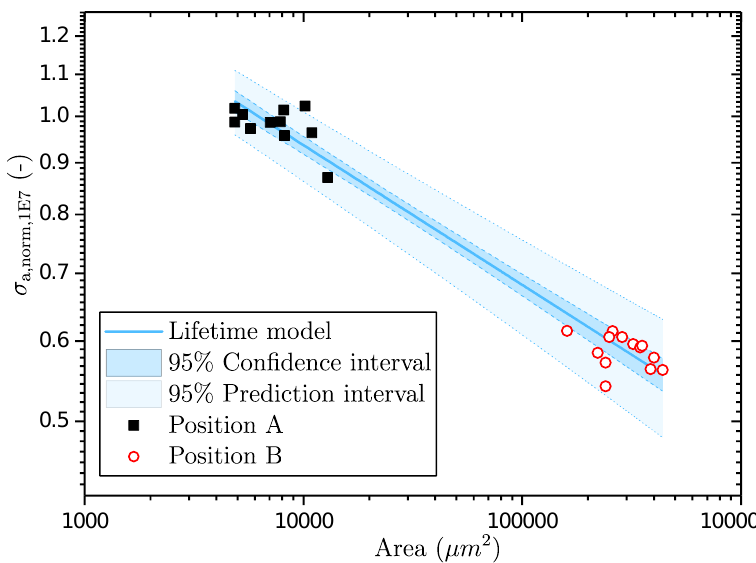
Figure 19. Defect based, probabilistic fatigue assessment